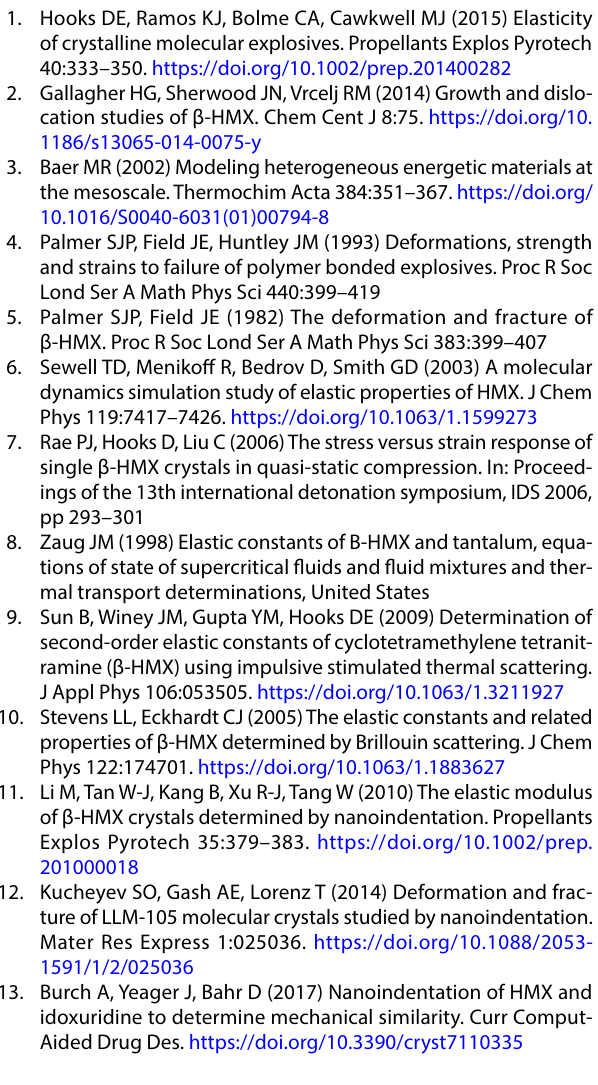
Fig. 11 Comparisons of exponent values in viscoplastic